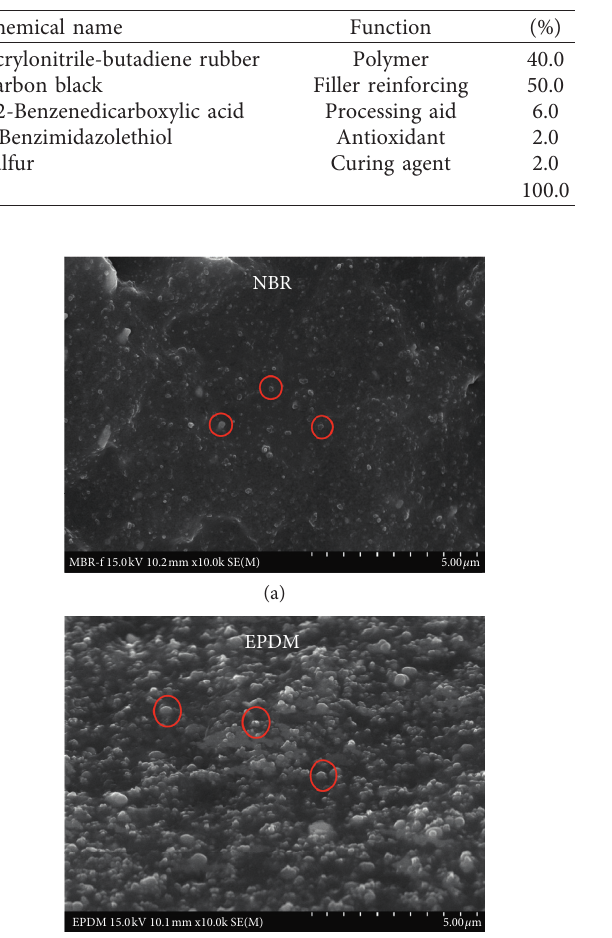
Figure 1: Molecular structure of NBR. Table 1: The chemical composition of the NBR rubber compound.